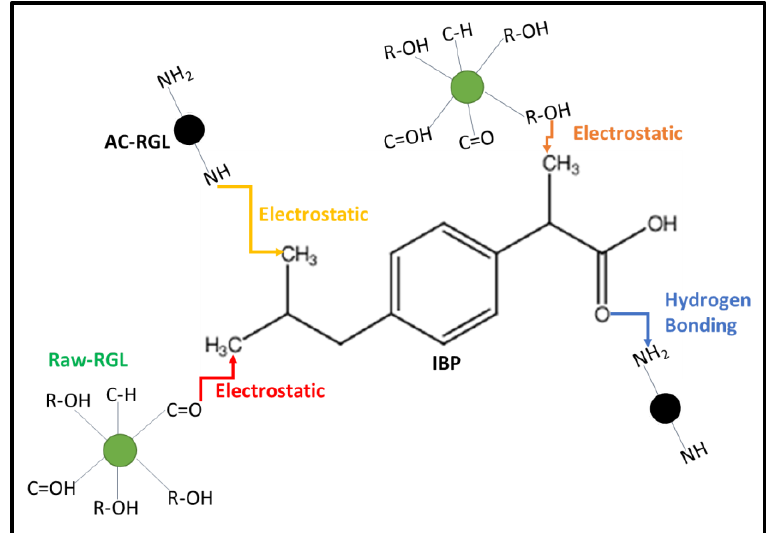
Figure 5. Proposed interaction of Raw-RGL and AC-RGL adsorbents with IBP.